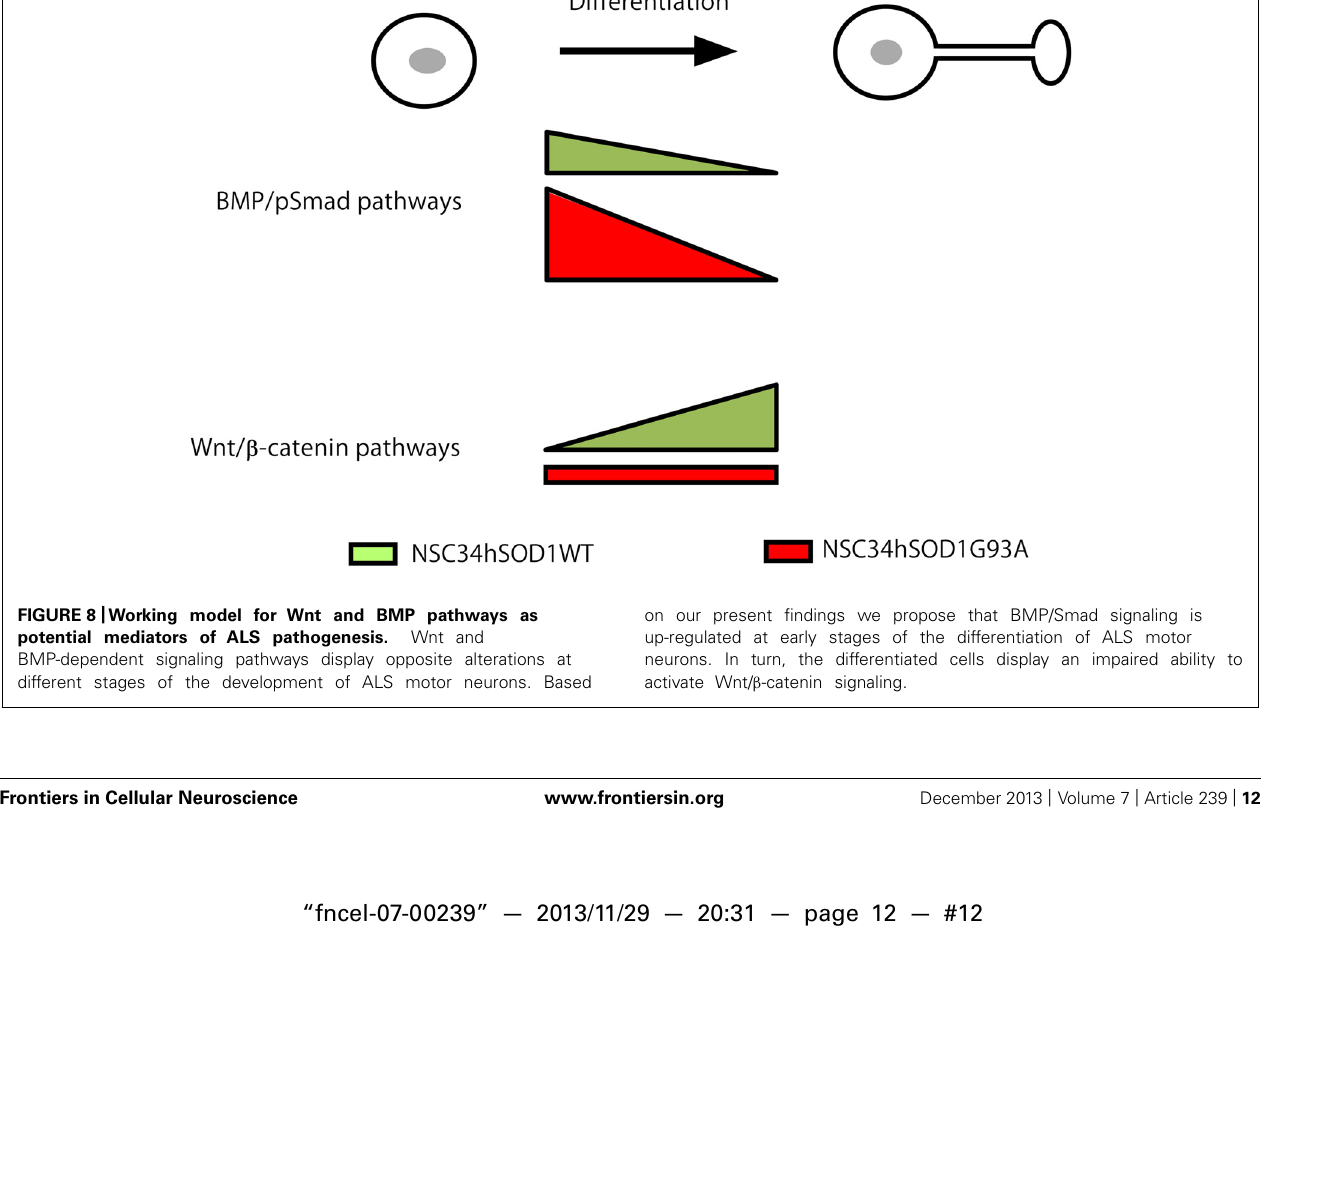
FIGURE 8 |Working model for Wnt and BMP pathways as potential mediators of ALS pathogenesis. Wnt and BMP-dependent signaling pathways display opposite alterations at different stages of the development of ALS motor neurons. Based